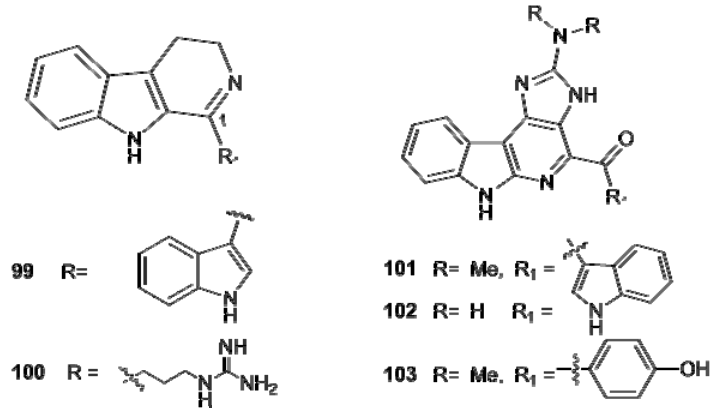
Figure 11. Structure of bengacarboline ( 98 ).